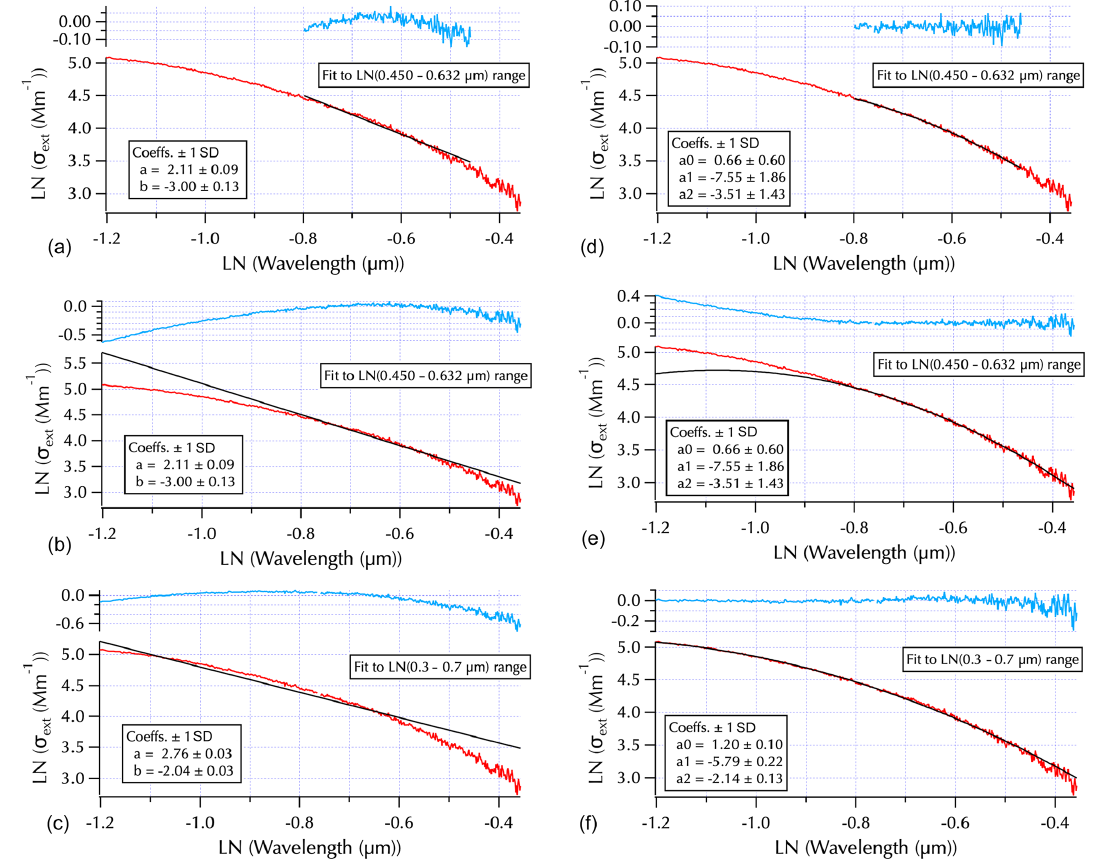
Figure 7. Example of wavelength dependence of LN( σ ext (Mm − 1 ) ) spectra (red curves) as a function of LN(wavelength (µm)). Linear ( y = a + b(x) , a–c ; here the intercept a = LN (β) , the value of LN( σ ext ) at 1µm where LN(1µm) = 0, and the slope b = − α ) and second- order polynomial ( y = a 0 + a 1 (x) + a 2 (x 2 ) , d–f ) fits (black curves) are shown with the fit residuals ( = LN (σ ext ( Mm − 1 )) – fit, blue curves). Residuals randomly distributed around zero indicate a good fit by the mathematical function used to fit the data, trends in residuals suggest another function may provide a better fit. Fits to the LN(0.450–0.632µm) subrange ( a, d ) and to the full range (LN(0.3–0.7µm), c, f ) are shown. Panels (b, e) show the extrapolation of the fit in panels (a, d) over the full measured wavelength range. The x axis labels of − 1.2, − 1.0, − 0.8, − 0.6, and − 0.4 are the natural log values for the wavelengths 0.301, 0.368, 0.449, 0.549, 0.670, and 0.698µm, respectively, i.e., equal to LN( λ